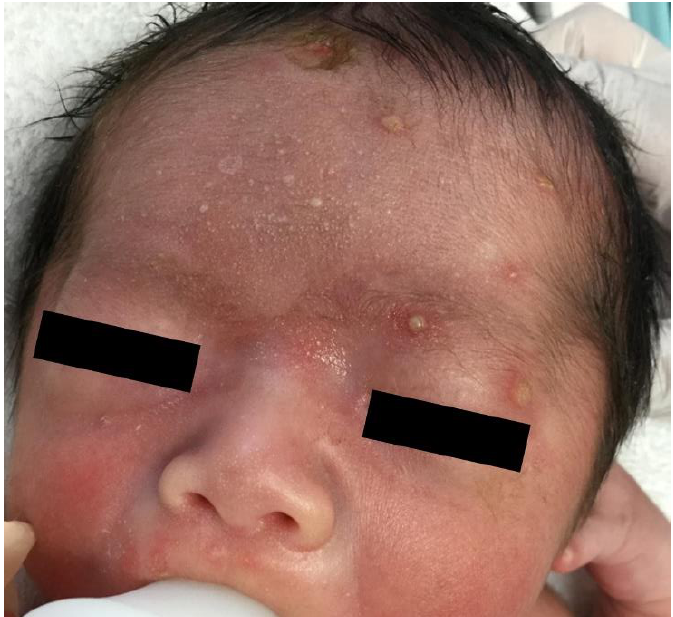
Figure 1. At birth, the patient developed multiple pustules measuring 1–5 mm and a few erosions with erythema on his scalp and forehead. Some pustules were crusted.